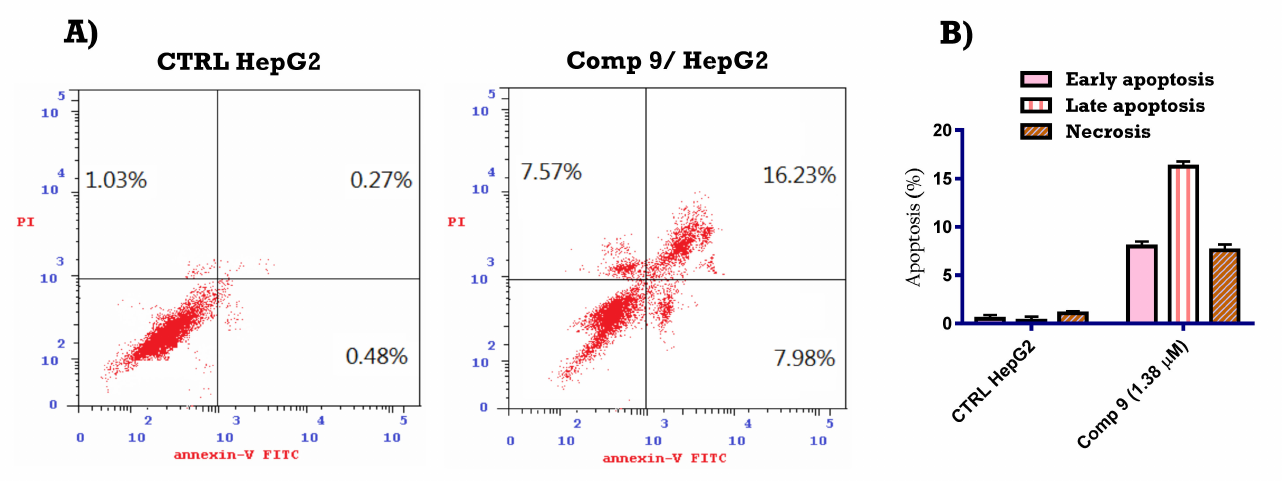
Figure 4. Compound 9 induces apoptosis in HepG2 cells. ( A ) HepG2 cells were treated with 1.38 µ M of compound 9 for 48 h. Cell apoptosis was quantized by Annexin V-FITC/PI dual staining assay using image-based cytometry. ( B ) The quantification of HepG2 cell